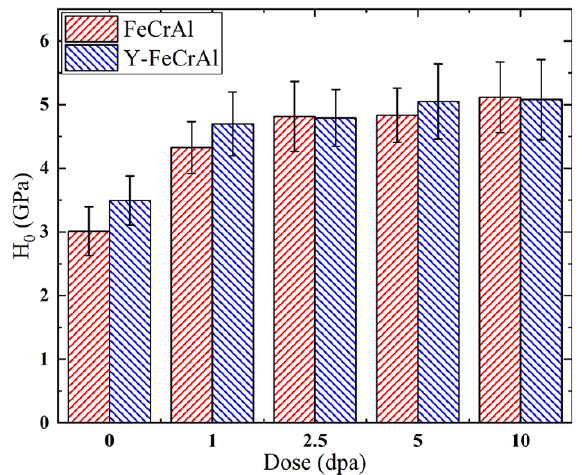
Figure 10. the value of 𝐻 (cid:2868) as a function of dose for before and after irradiation.